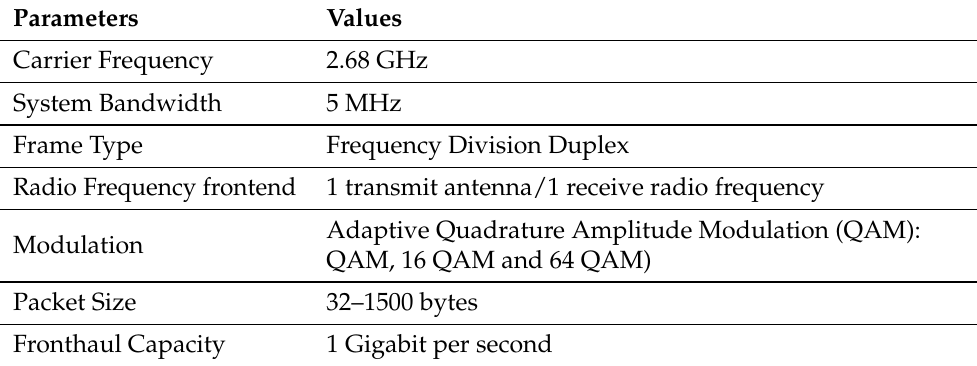
Figure 2. End-to-end system experimental setup for multi-path fronthaul with erasure coding (MPC) for downlink communication with medium access control (MAC) and physical (PHY) layer split, with an illustration of data encoding in the (CU + DU) entity and decoding in the RU entity. Table 1. Open Air Interface